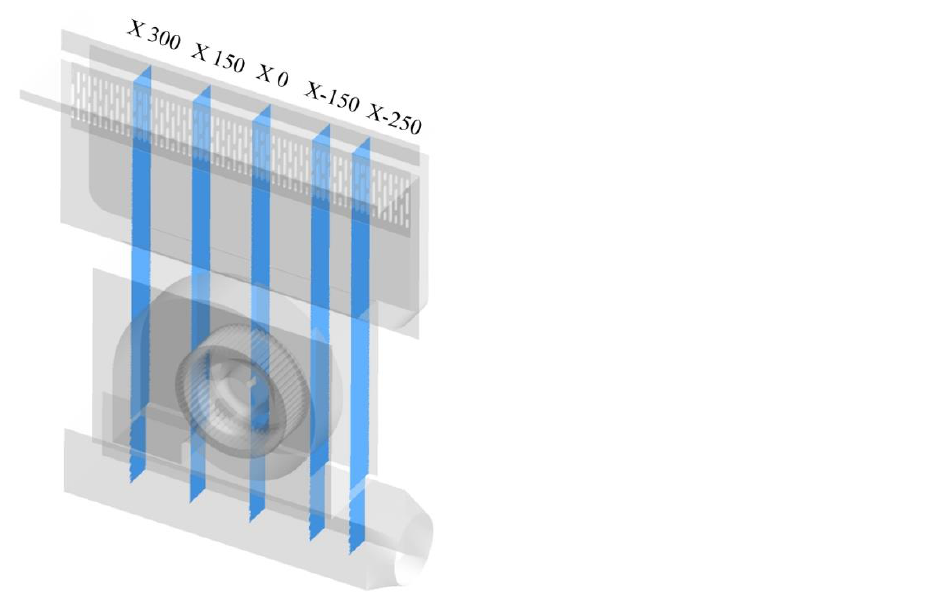
Figure 6. Position calibration of the X-directional section within the prototype head duct of the integrated stove.